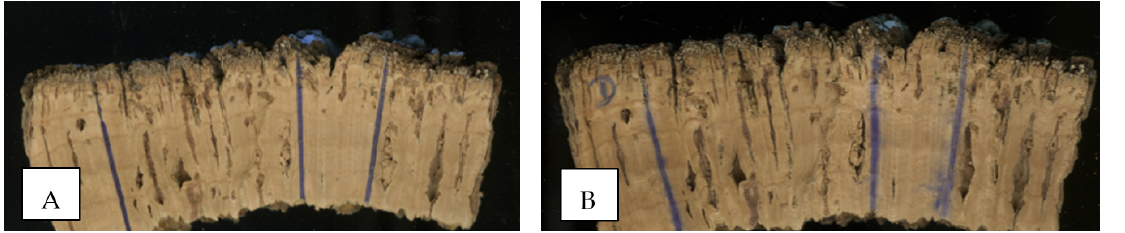
Figure 2. Example of a macrosample from the irrigated plot: ( A ) before the boiling procedure; ( B ) after the boiling procedure .